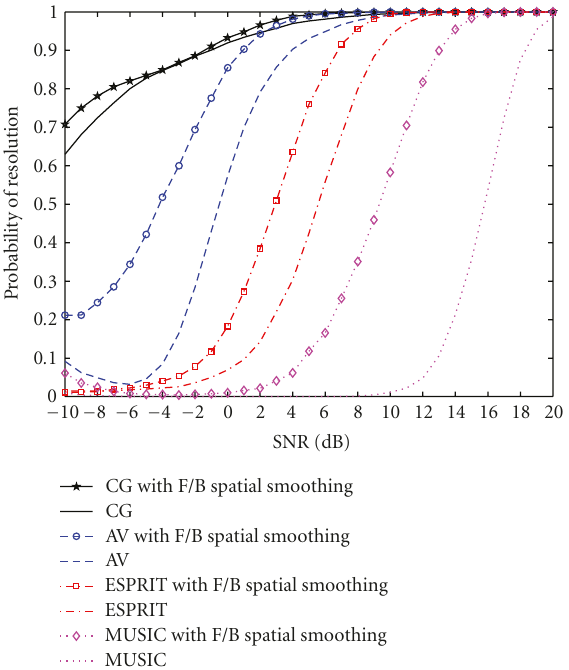
Figure 4: Probability of resolution versus SNR (separation 3 ◦ , K = 50, r = 0 . 7).